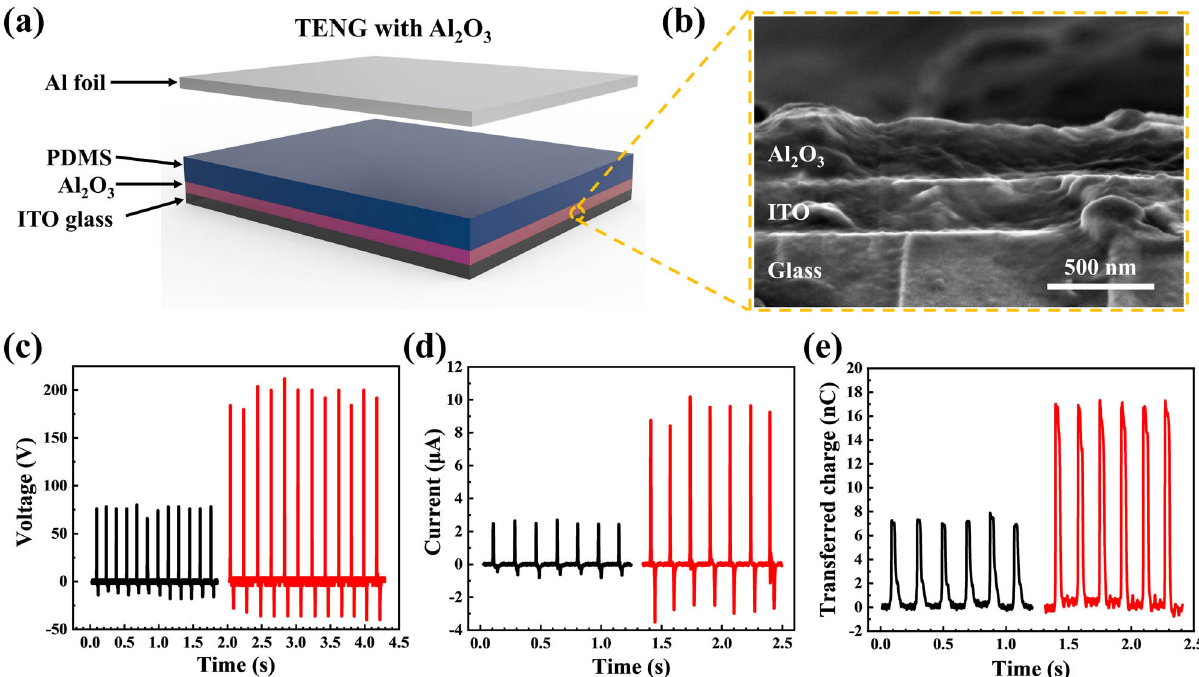
Figure 5: Device structure and performance of the TENG with CLD - Al 2 O 3 layer. ( a ) Schematic diagram of the TENG device with the Al 2 O 3 layer. ( b ) A cross - sectional view of SEM image of the Al 2 O 3 /ITO glass sample showing the sharp interfaces between di ff erent materials. ( c ) Open - circuit voltage of the TENG without ( black ) /with ( red ) the Al ( d ) Short - circuit current of the TENG without ( black ) /with 2 O 3 layer. ( red ) the Al ( e ) The amount of transferred charge of TENG without ( black ) /with ( red ) Al 2 O 3 layer. 2 O 3 .